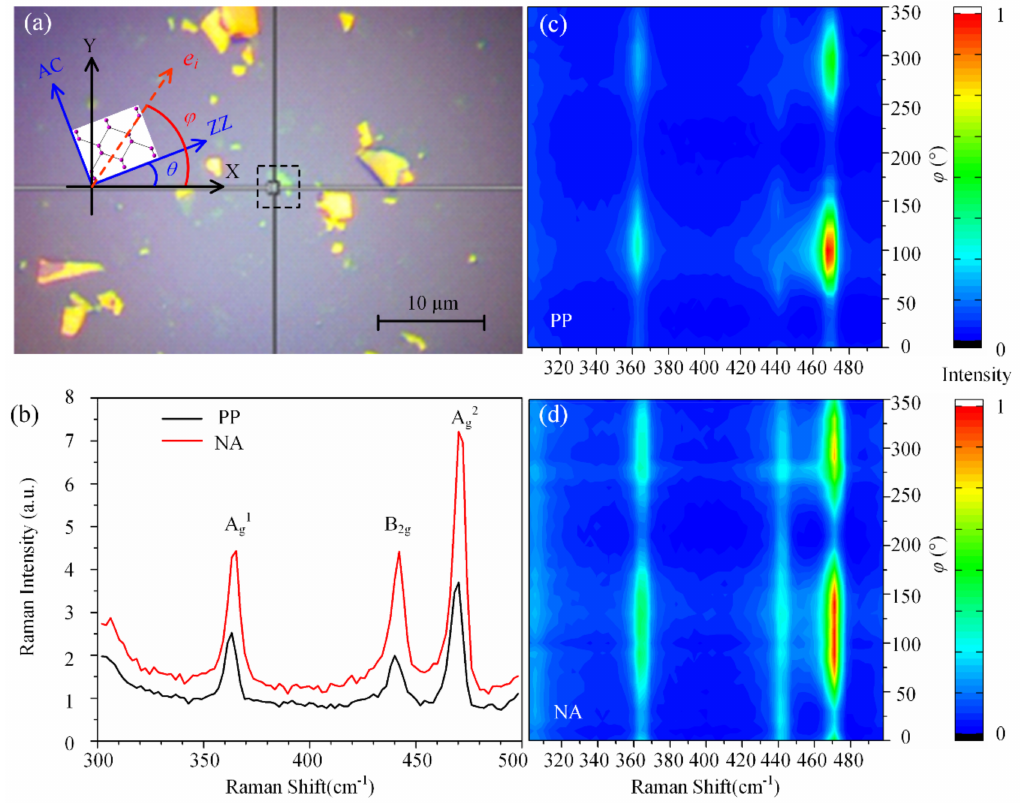
Figure3. ( a )Opticalmicroscopeimageofthethree-layersblackphosphorussample, ( b )Ramanspectrum when the polarization angle of incident laser at 0 ◦ under the parallel polarization (PP) and nonanalyzer (NA) configurations, ( c , d ) normalized Raman intensity (300–500 cm − 1 ) with the polarization direction change of the incident laser from 0 ◦ to 360 ◦ under the PP and NA configurations,